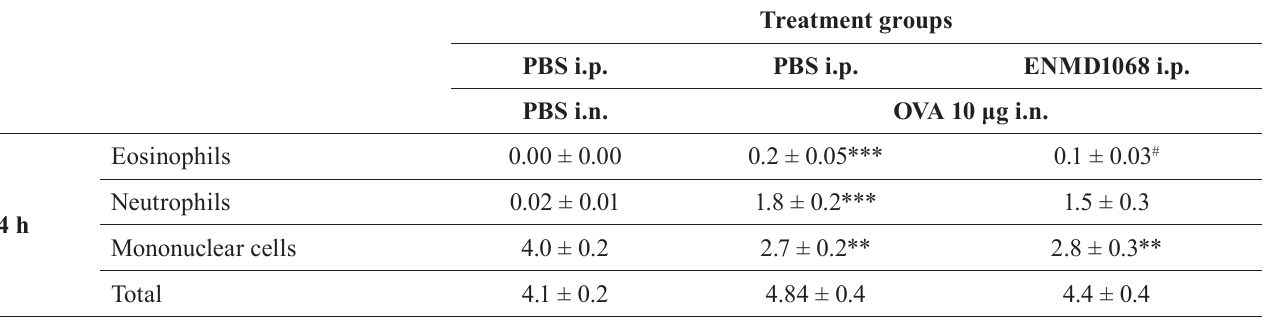
TABLE I - T otal and differential cell counts (x 10 5 cells) in BALF 4h or 24 h after i.n. instillation of OVA in PAR-2 antagonist ENMD1068-treated sensitized